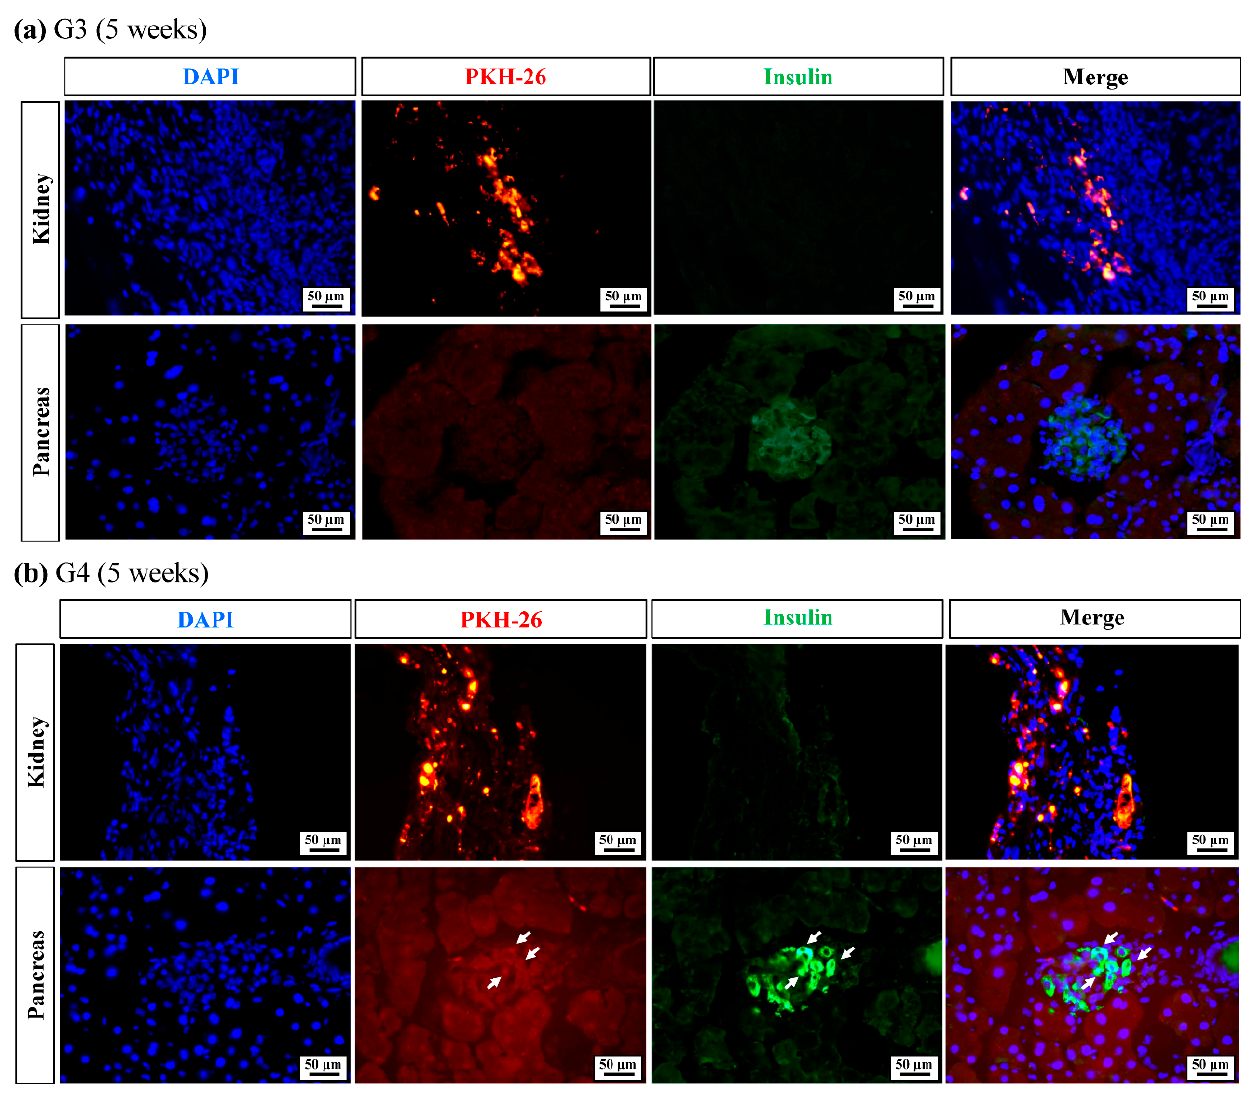
Figure 7. Application of cell therapy agents in a T1D mouse model. All fluorescently stained cells were observed under a ( a ) ×40 objective and a ( b ) ×50 objective, and representative images are shown. The white arrows indicate merged cells. Abbreviations: G, group; DAPI, 4 ′ ,6-diamidino-2-phenylindole.